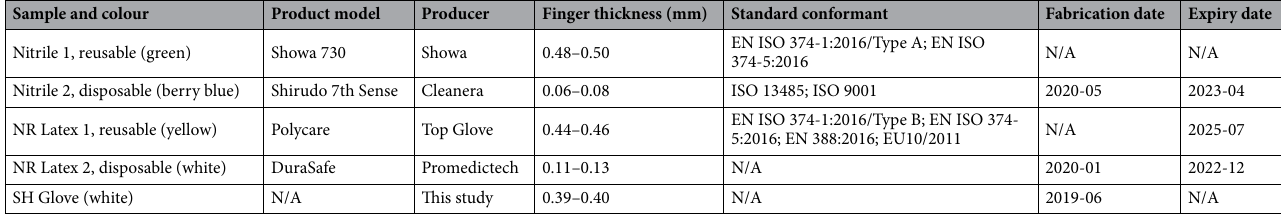
Table 4. A comparison table showing different types of